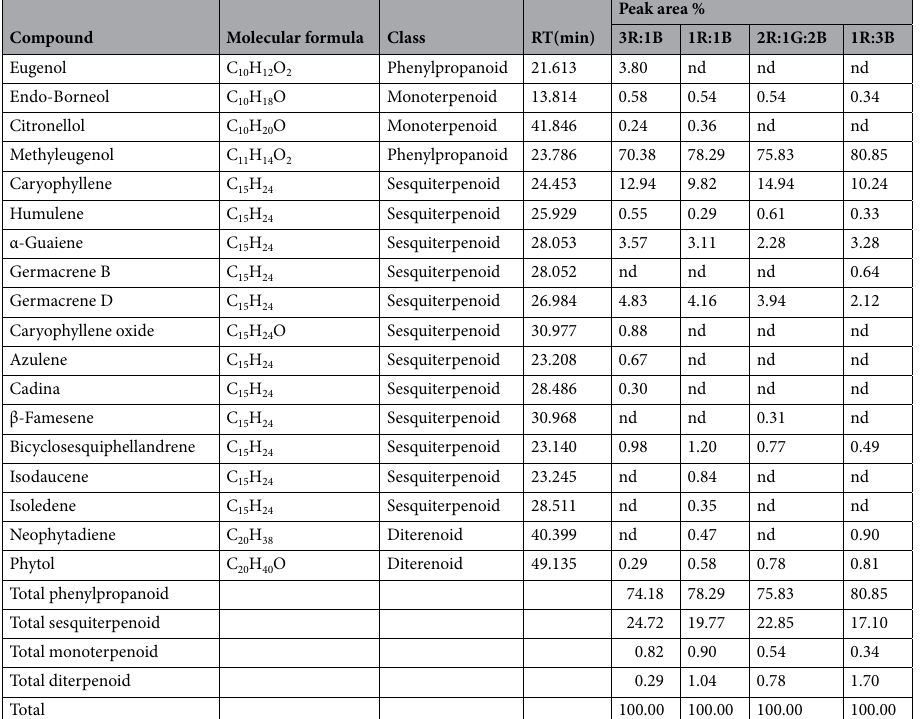
Table 3. Chemical profiling of green holy basil under different light spectrum ratios (3R:1B, 1R:1B, 2R:1G:2B, and 1R:3B) at flowering stage. “nd” indicates not detected . R, G and B represent the red, green and blue llight spectra, respectively, and number before the letters stand for the ratio of each lighrt spectra.